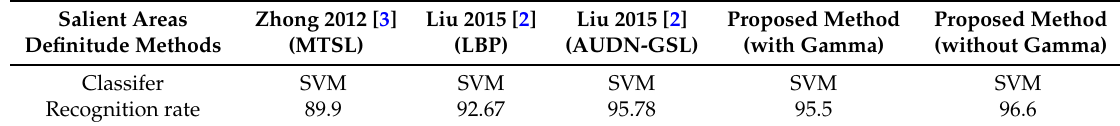
Table 3. Recognition rate on CK+ under different salient areas definitude